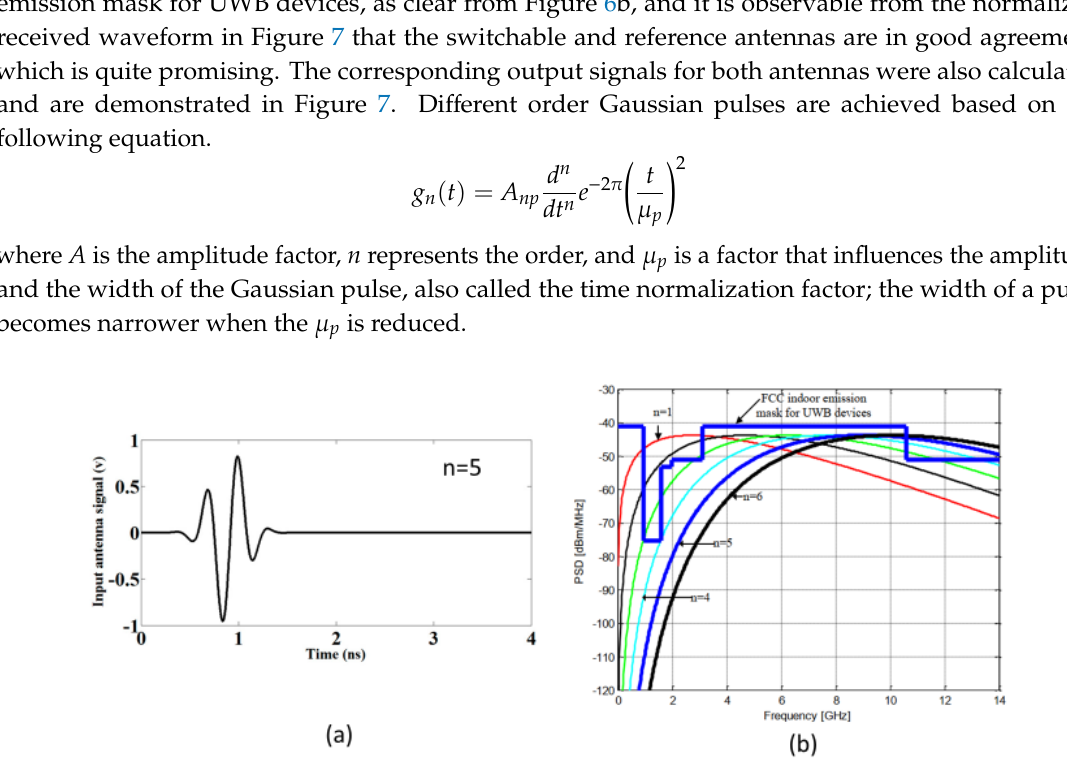
Figure 6. ( a ) Incident pulse used for excitation with n = 5; ( b ) The power spectral density (PSD) of the different derivatives of Gaussian pulses.